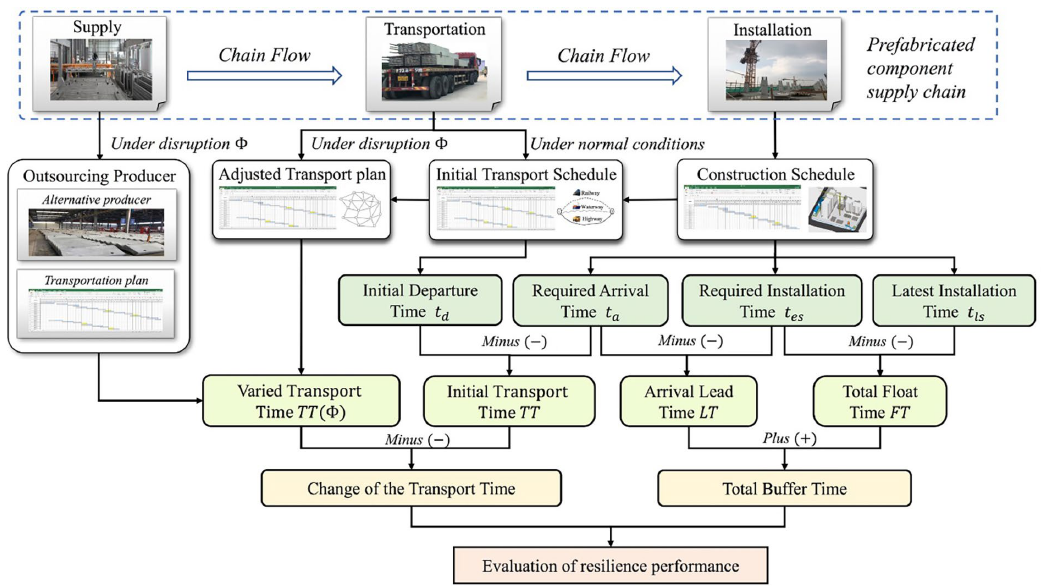
Figure 2. Framework for quantitatively evaluating the resilience performance of each delivery